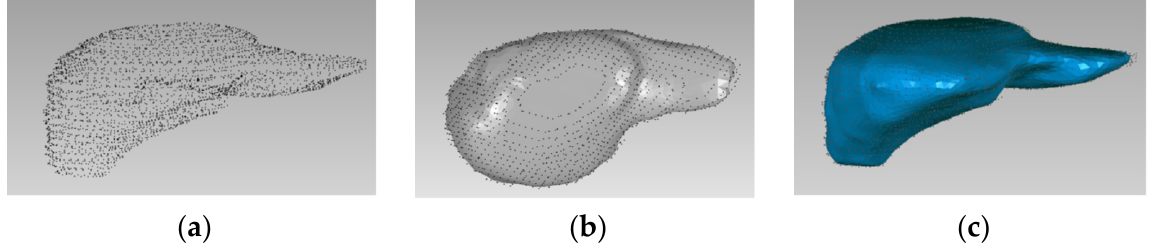
Figure 2. Liver segment extraction. Extraction of hepatic parenchyma ( a ) by fully automated or semi-automated methods by delineating liver boundaries from neighboring tissue ( b ). The proce- dure was applied in each one of the DICOM images of the artery CT scan phase.